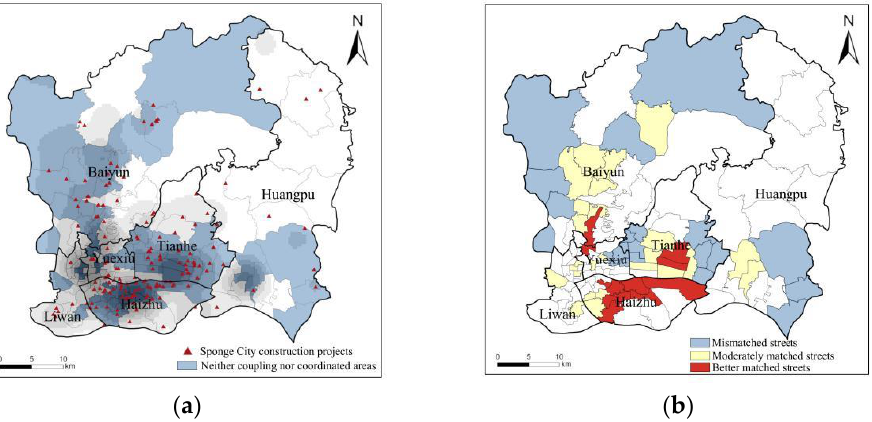
Figure 7. ( a ) Nuclear density analysis for Sponge City construction projects; ( b ) Results of matching CCD dysfunctional areas of Sponge City construction projects.